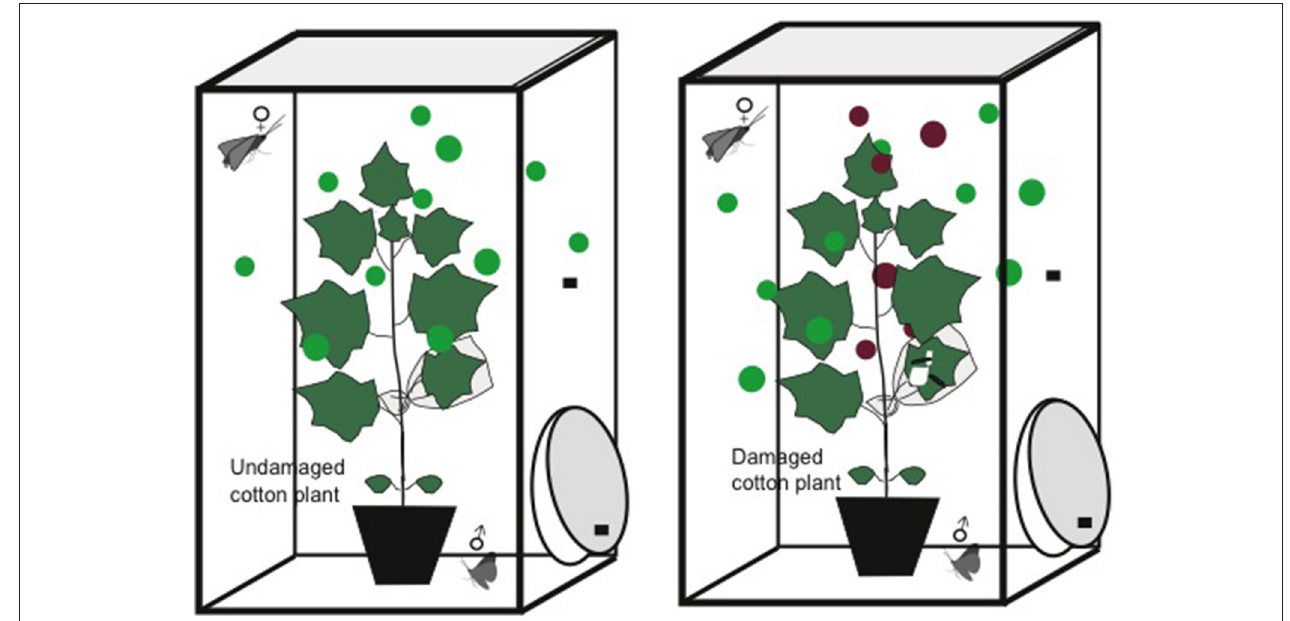
FIGURE 1 | Mating set-up: A herbivore-damaged or undamaged cotton plant was placed inside a Plexiglas cage and moths were introduced. Each cage had openings at the top, with a moveable lid, and one of the side walls from which the plants and insects could be